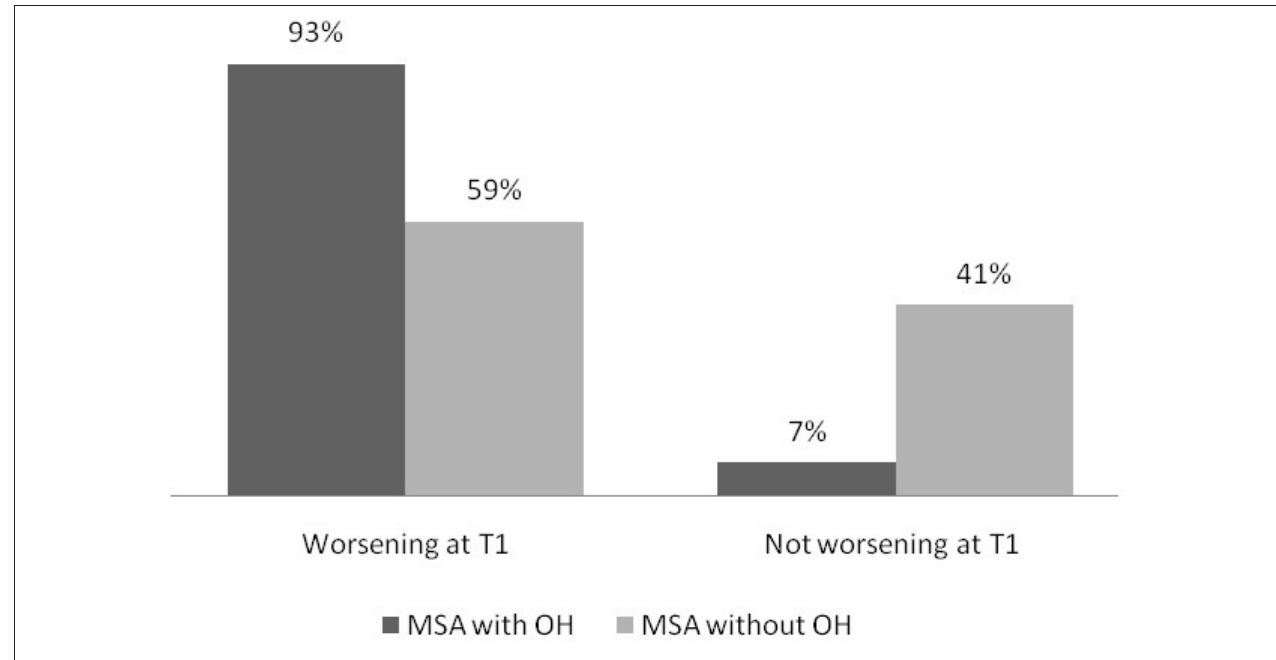
FIGURE 1 | Percentage of MSA patients with and without OH according to change in global cognitive status at T 1 . MSA, multiple system atrophy; OH, orthostatic hypotension; T 1 , follow up